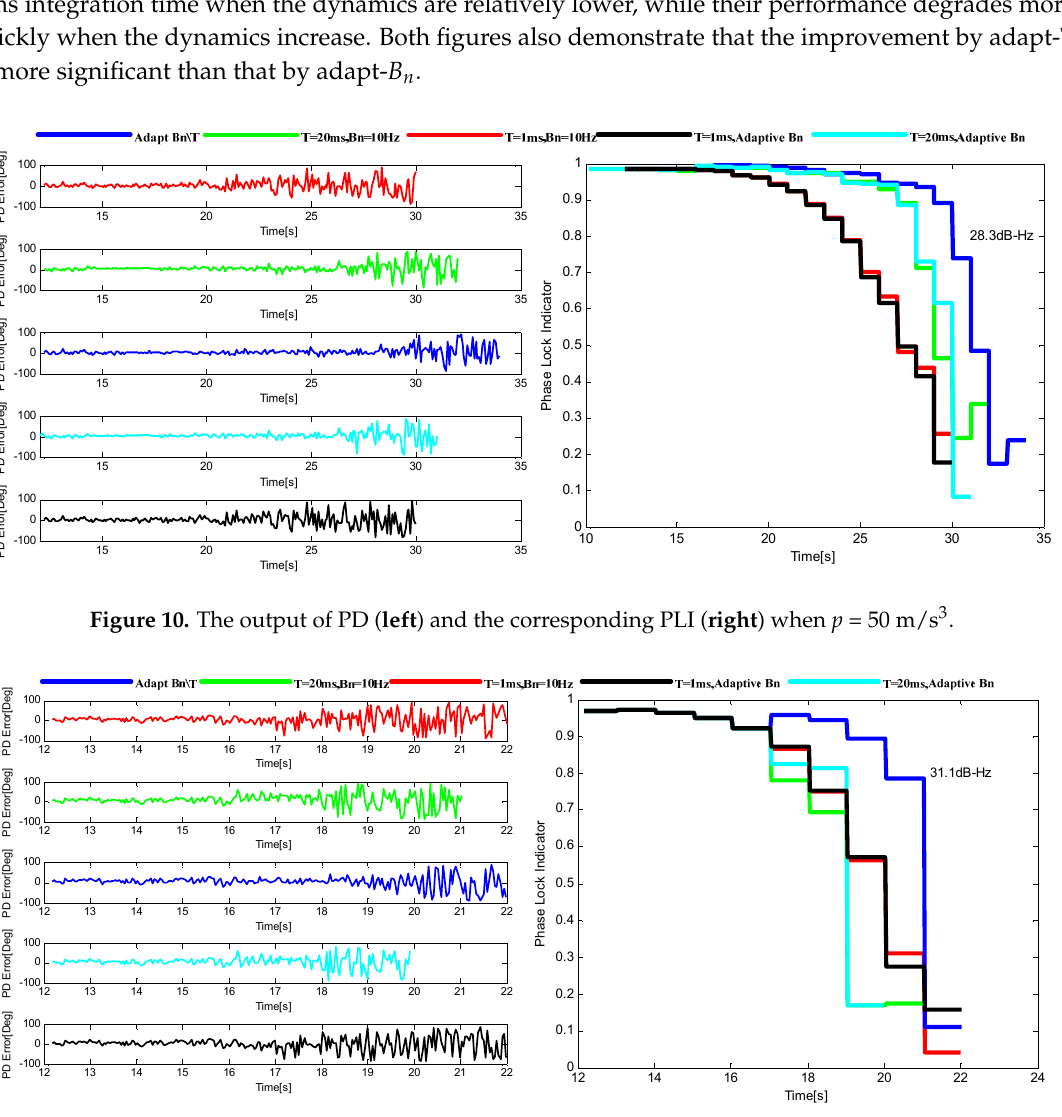
Figure 11. The output of PD ( left ) and the corresponding PLI ( right ) when p = 200 m/s 3 .